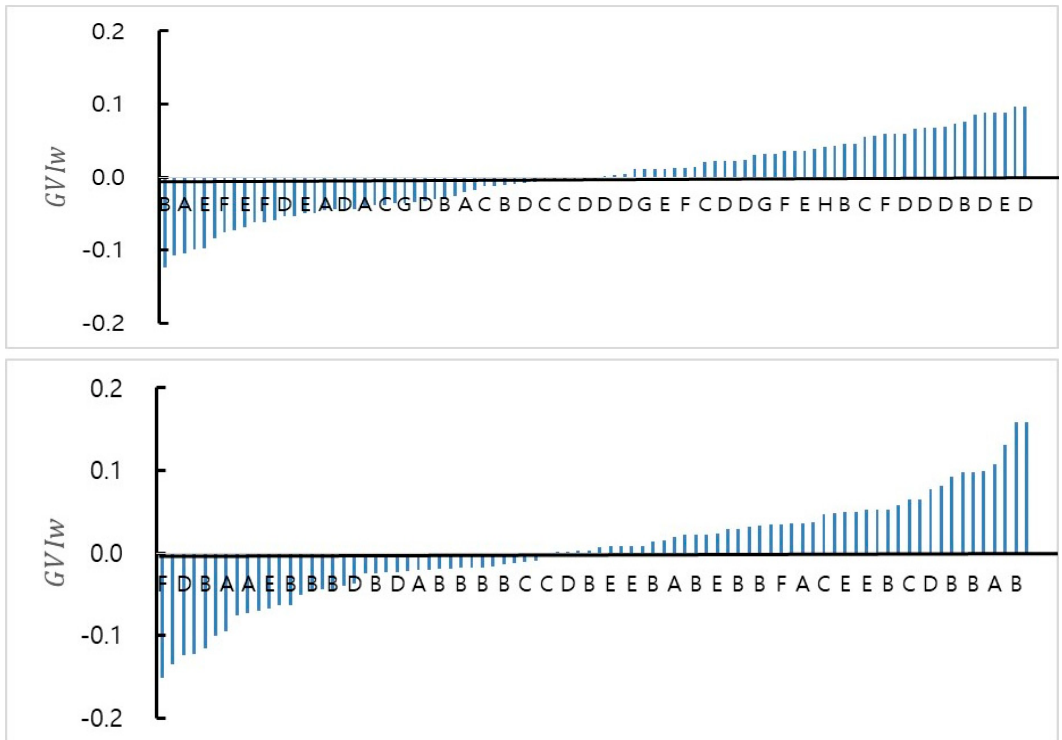
Figure 2. Truncation selection of candidate trees based on GVI w values in Quercus salicina ( top ) and Q. glauca ( bottom ) . If GVI w > 0, then accepted and if GVI w < 0, then rejected. Capital letters indicate the group to which each individual belongs.